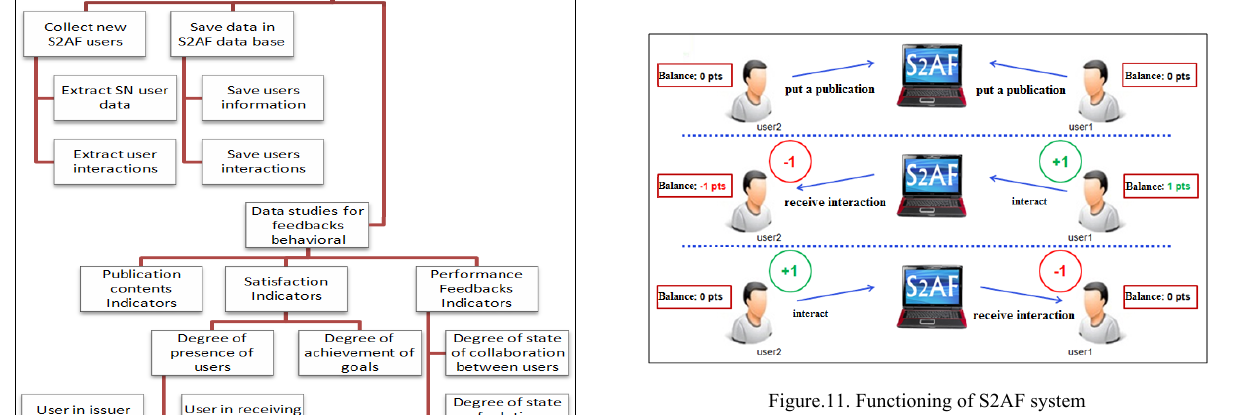
Figure.11. Functioning of S2AF